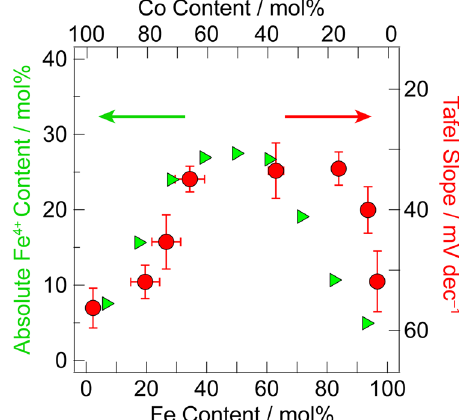
Fig. 2 Correlation of Tafel slope with Fe 4 + composition. Overlay of Tafel slope (red circle) with absolute Fe 4 + (green triangle) population in CoFeO x fi lms with increasing Fe content. Tafel measurements were run in triplicate, and the average value is shown on the graph at 95% con fi dence limits.